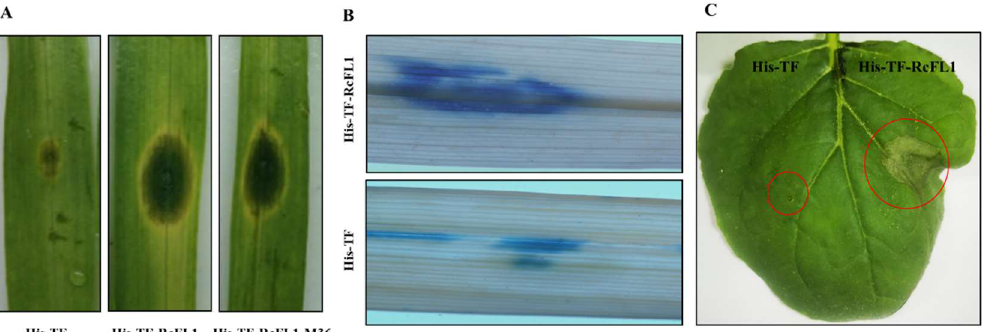
Figure 5. RcFL1 induces plant cell death shown as leaf lesions in wheat and N. benthamiana . ( A ) RcFL1 and its M36 domain cause lesions in infiltrated leaves of the susceptible- R. cerealis wheat cv. Wenmai 6; ( B ) trypan blue staining of wheat cv. Wenmai 6 leaves infiltrated with His-TF-RcFL1 or His-TF. Dead wheat leaf cells were stained by trypan blue. ( C ) RcFL1 can induce the cell death in N. benthamiana . Each heterologously-expressed protein, His-TF-RcFL1, His-TF-RcFL1-MEP36 or His-TF, was infiltrated in 25 µL (concentration 5 µM/L). Six leaves were used in each experiment and repeated three times. Red circles represent the sites of His-TF and His-TF-RcFL1 protein infiltration or the cell-death occurring.